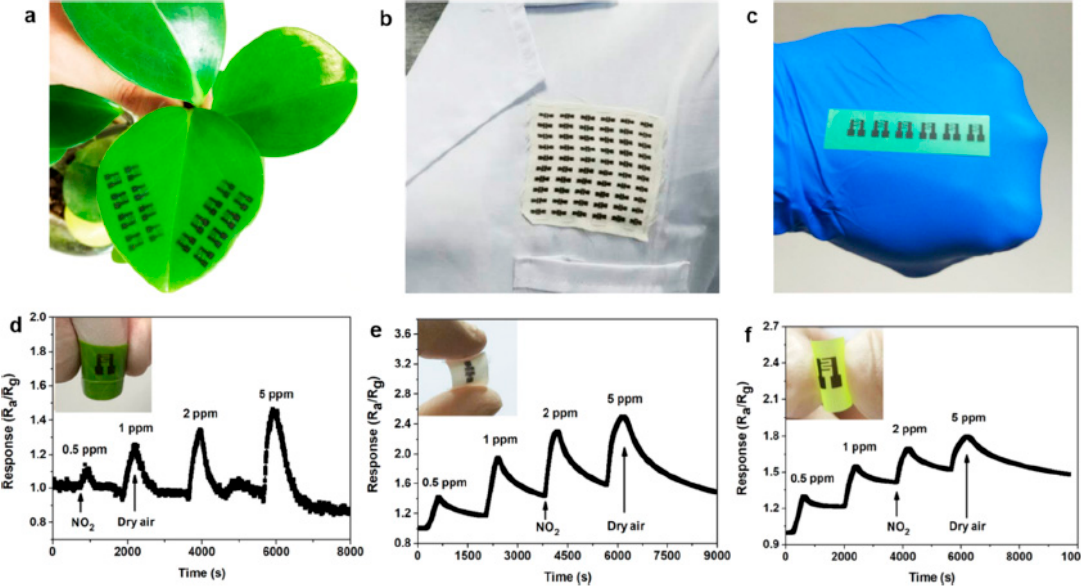
Figure 16. Photographs of gas sensor arrays prepared on ( a ) living plant leaf, ( b ) silk stitched onto a lab coat, and ( c ) portable sticker attached onto the human body. Dynamic responses are shown for the samples fabricated on ( d ) leaf, ( e ) silk, and ( f ) portable sticker [168] (reproduced with permission).